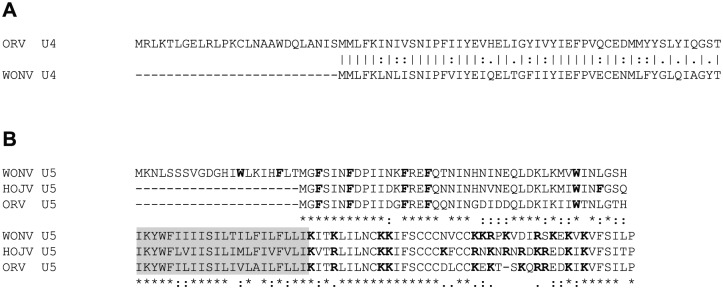
(A) Global (EMBOSS Needle) pairwise alignment of the putative U4 proteins of ORV and WONV encoded by an ORF overlapping the N gene. The homologous 49-aa region of the 75-aa ORV U4 demonstrates 88% amino acid similarity to the 49-aa WONV U4. (B) MUSCLE alignment of the U5 proteins (hypothetical viroporins) of WONV, HOJV, and ORV. Fully conserved (*), strongly conserved (:), and weakly conserved (.) amino acids are marked. Predicted transmembrane regions are shaded. Aromatic residues (F and W) in the N-terminal domain and basic residues (K and R) within the C-terminal domain are given in bold. Six conserved cysteine residues in the C-terminal domains are marked by the boxes. HOJV indicates Holmes Jungle virus; ORV, Ord River virus; WONV, Wongabel virus.